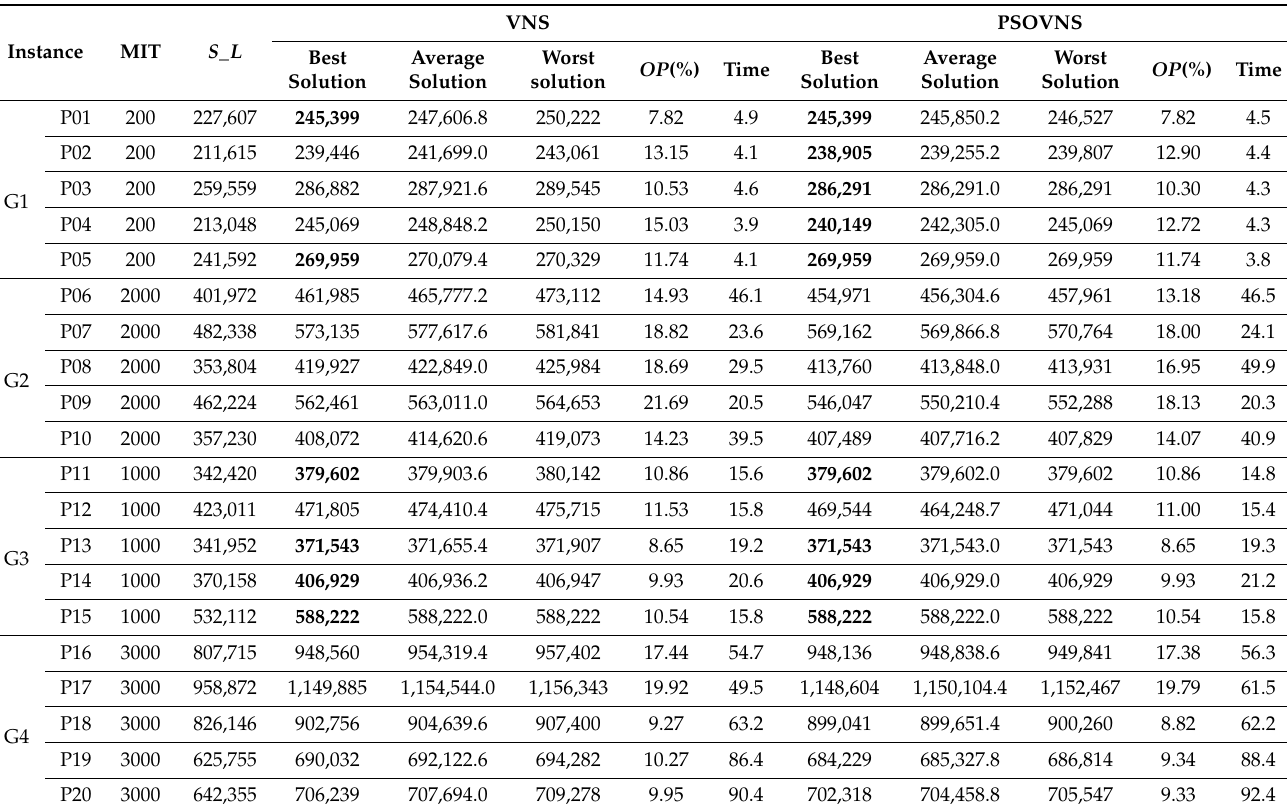
Table 13. Result of VNS and